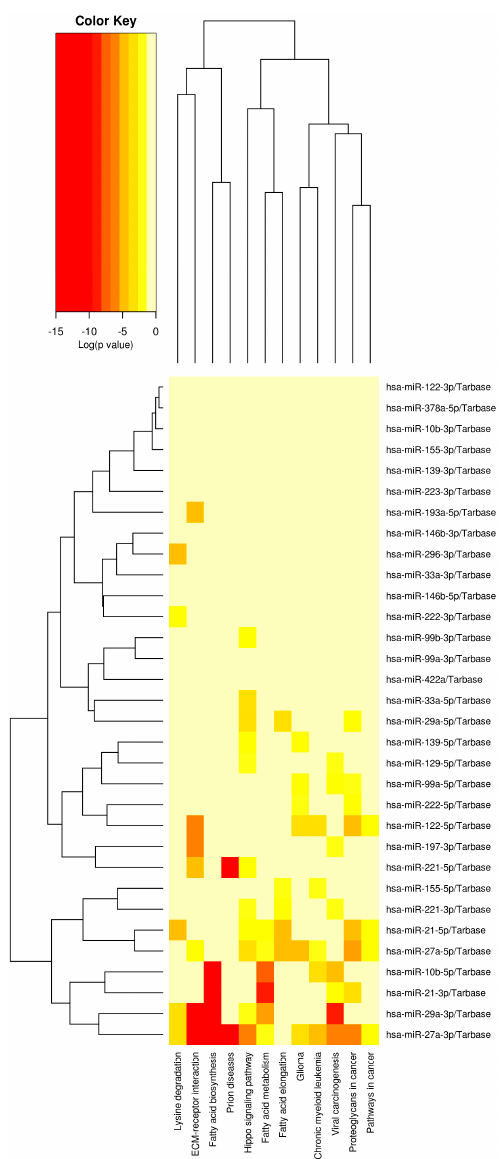
Figure 2. Cluster analysis and the heatmap of the relationship with the pathways of miRNAs.